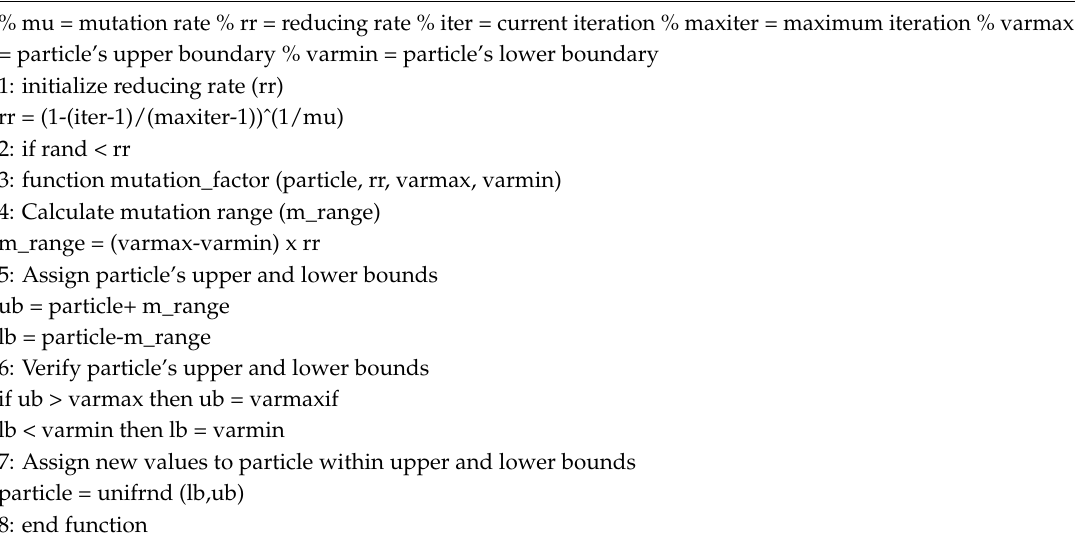
Algorithm 1. Pseudocode for the mutation